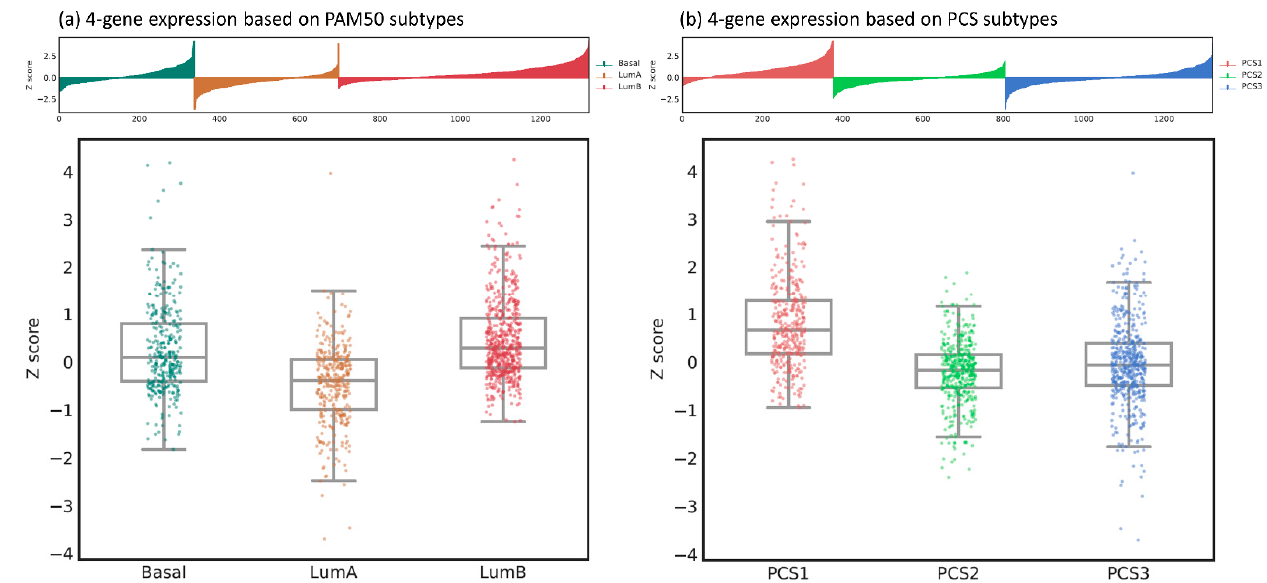
Figure 5. The expression of the 4-gene panel based on ( a ) PAM50 and ( b ) PCS subtypes.